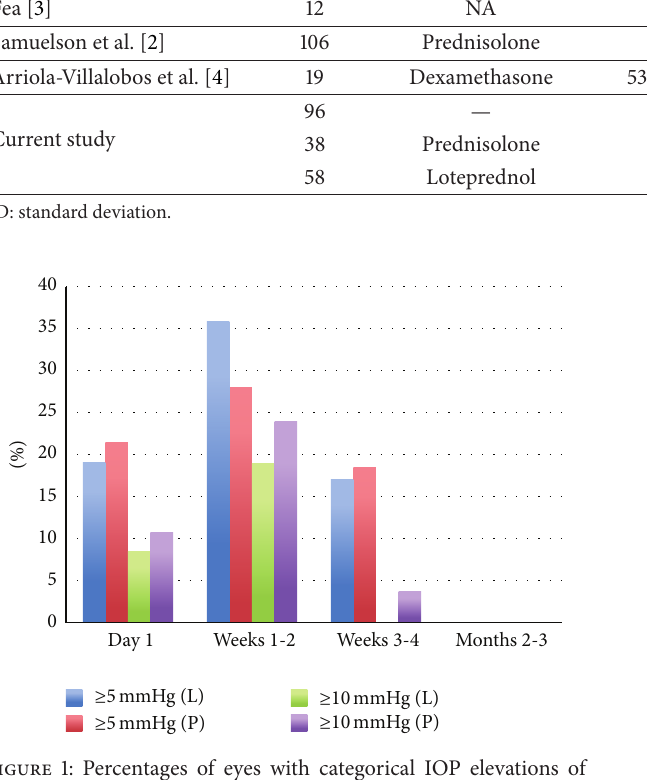
Figure 1: Percentages of eyes with categorical IOP elevations of ≥ 5 mmHg and of ≥ 10mmHg.